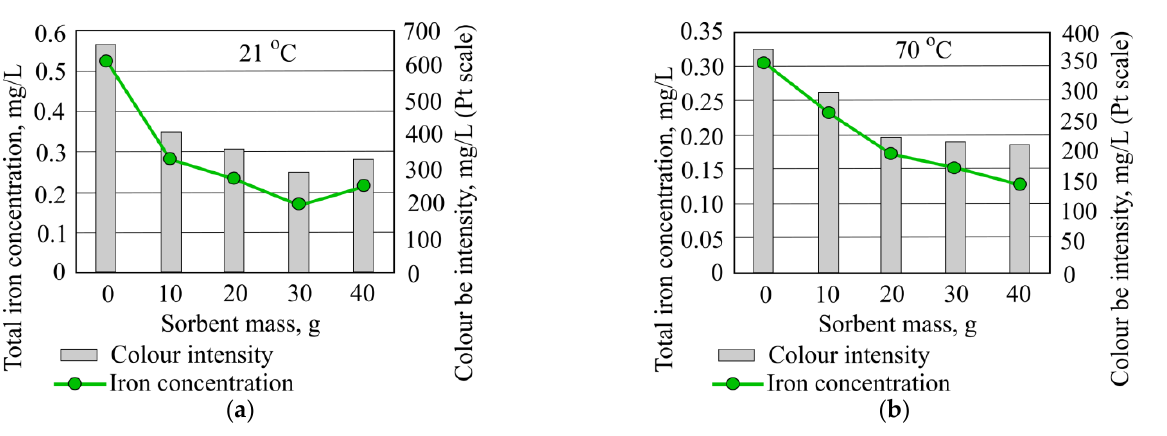
Figure 15. Total iron concentration and color intensity when investigated water is at ( a ) 21 °C and ( b ) 70 °C using granulated mineral sorbent.